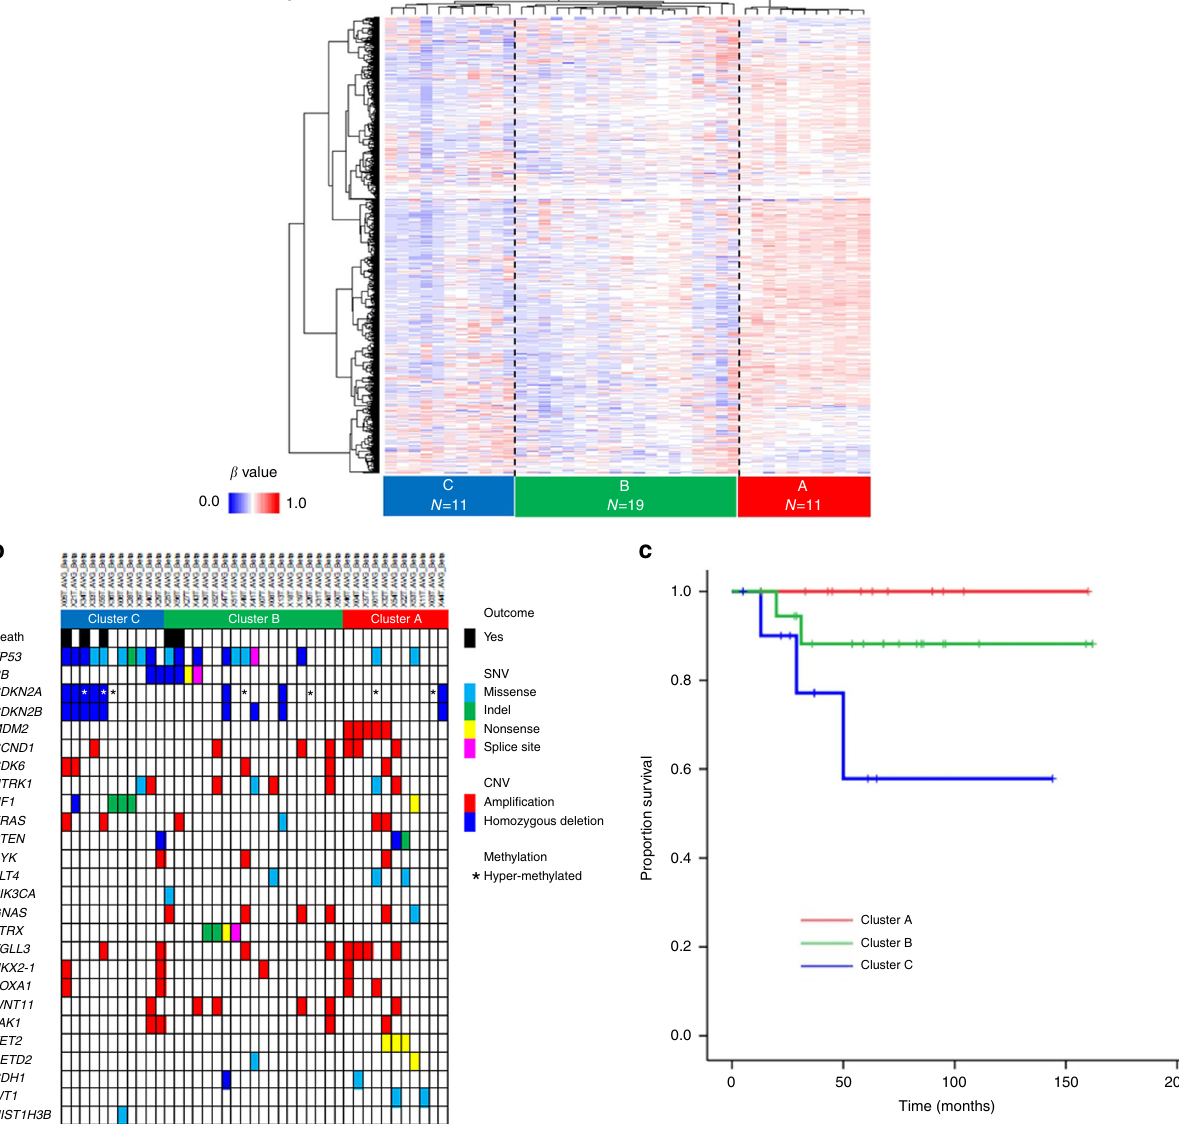
Fig. 4 DNA methylation pro fi ling and integrated analysis. a Unsupervised hierarchical clustering of DNA methylation in MFS. The heat map shows DNA methylation pro fi les of 41 MFSs. Three clusters were identi fi ed in 41 MFSs: Clusters A, B, and C. Red indicates hyper-methylation, and blue indicates hypo- methylation. b Correlations of DNA methylation clusters with genetic alterations. The horizontal axis represents each tumor. Each cluster was characterized by unique genetic alterations: MDM2 ampli fi cation and alterations of histone/chromatin modi fi ers in Cluster A; TP53 and ATRX alterations in Cluster B; and TP53 , CDKN2A/B , and NF1 alterations in Cluster C. c Kaplan – Meier plots of overall survival of patients segregated by three DNA methylation clusters. p -value was calculated by log-rank (Supplementary Figs. 4 and 5 and Supplementary Table 3). Alterations of any of cell cycle regulators ( RB1 , CDKN2A , CDKN2B , CCND1 , and CDK6 ) were associated with poorer overall survival ( p = 0.001, log-rank test) (Supplementary Fig. 4m). RB1 ( p = 0.040, log-rank test), CDKN2A ( p < 0.001, log-